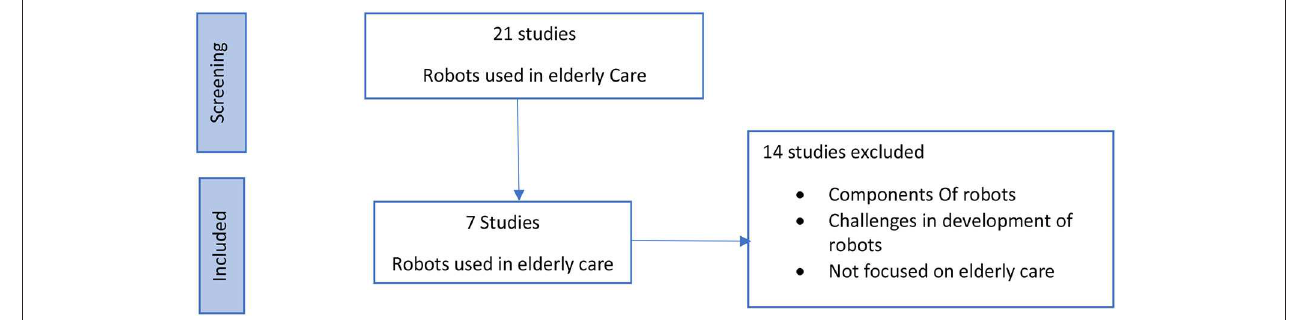
FIGURE 2 | Robots used in elderly care—flow diagram of search